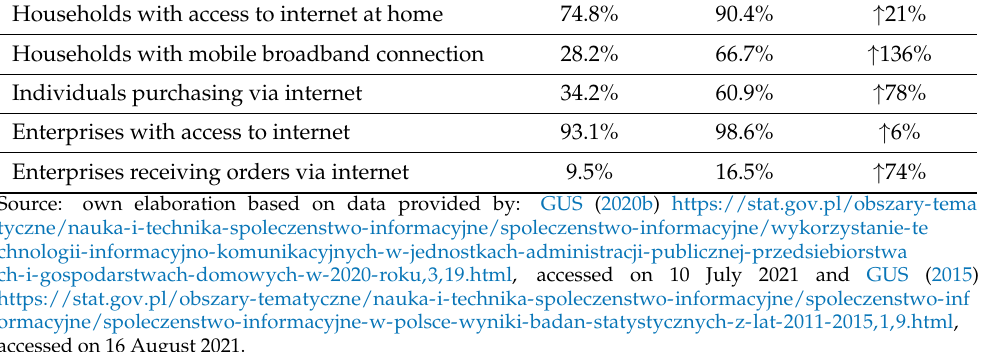
Table 4. Internet access as the key factor determining the development of m-payments.